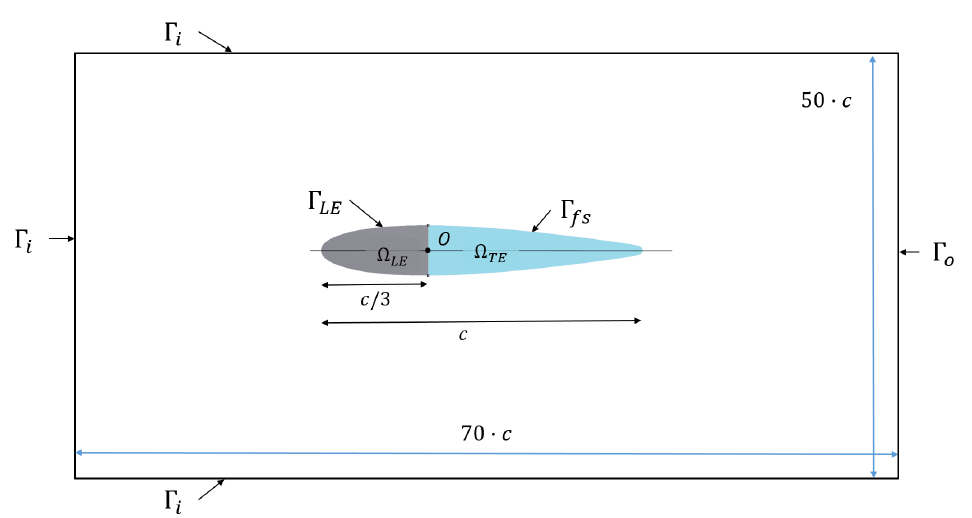
Figure 2. Partly deformable hydrofoil geometry, fluid, and solid domains boundaries: Ω LE (gray) is non deformable and Ω TE (cyan) is deformable.